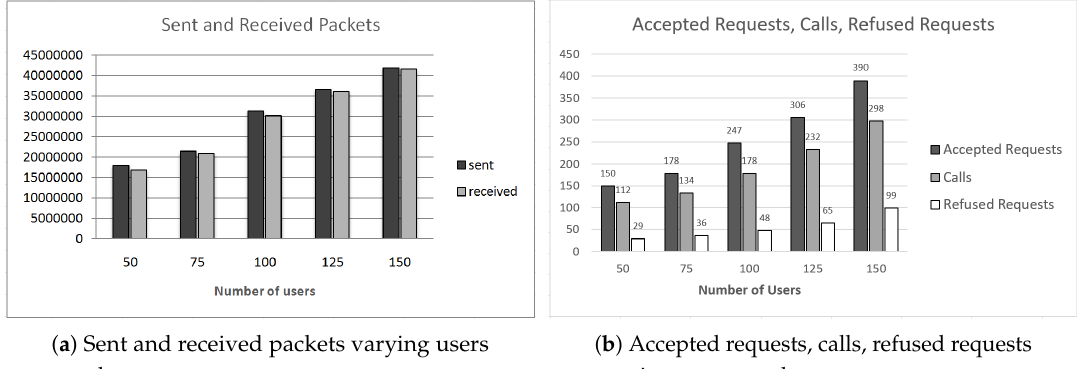
Figure 10. Curves on packets and requests number.